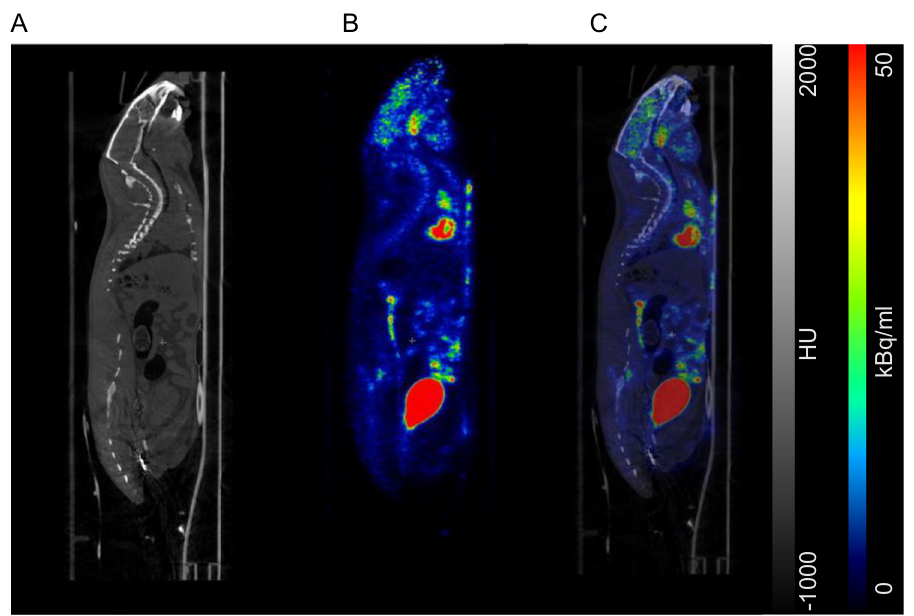
Fig. 1 PET/CT sequence of images (CT, PET and PET/CT) of a rat with a myocardial infarct following injection of [ 18 F]FDG administered via bolus injection into the tail vein. High [ 18 F]FDG tracer uptake is seen in the heart as well as the discharge in the bladder. Panel A displays the CT (X-ray) anatomical information. Panel B shows the PET image (functional information). Panel C displays the PET/CT fused images. Scale shows CT Hounsfield units (HU) and PET tracer uptake in kBq/ml. McDougald W. PET/CT. In: Imaging Modalities for Biological and Preclinical Research: A Compendium, Volume 2. IOP Publishing; 2021:III.2.a-1-III.2.a-12. https:// doi. org/